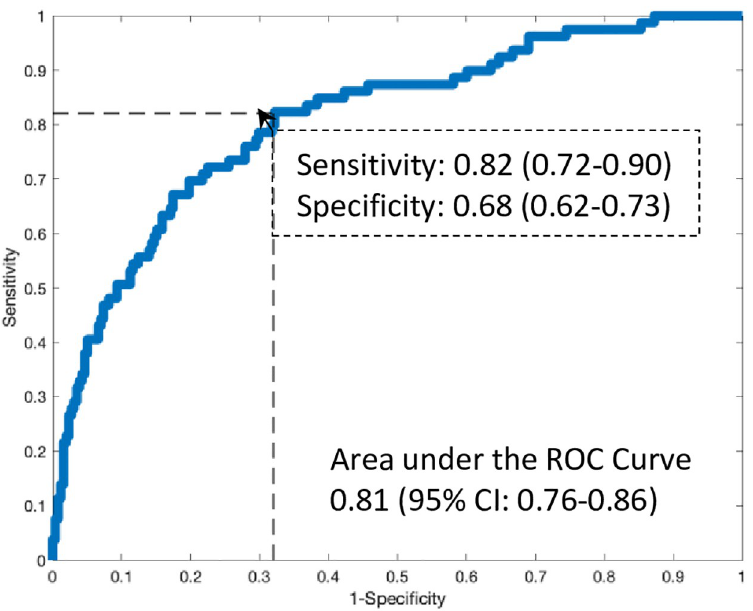
Fig 4. Performance of the machine-learned predictor.